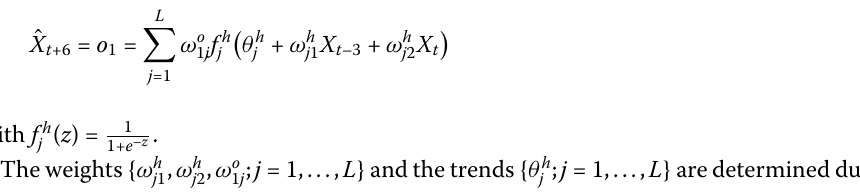
The predictor given by the neural network has the following expression: